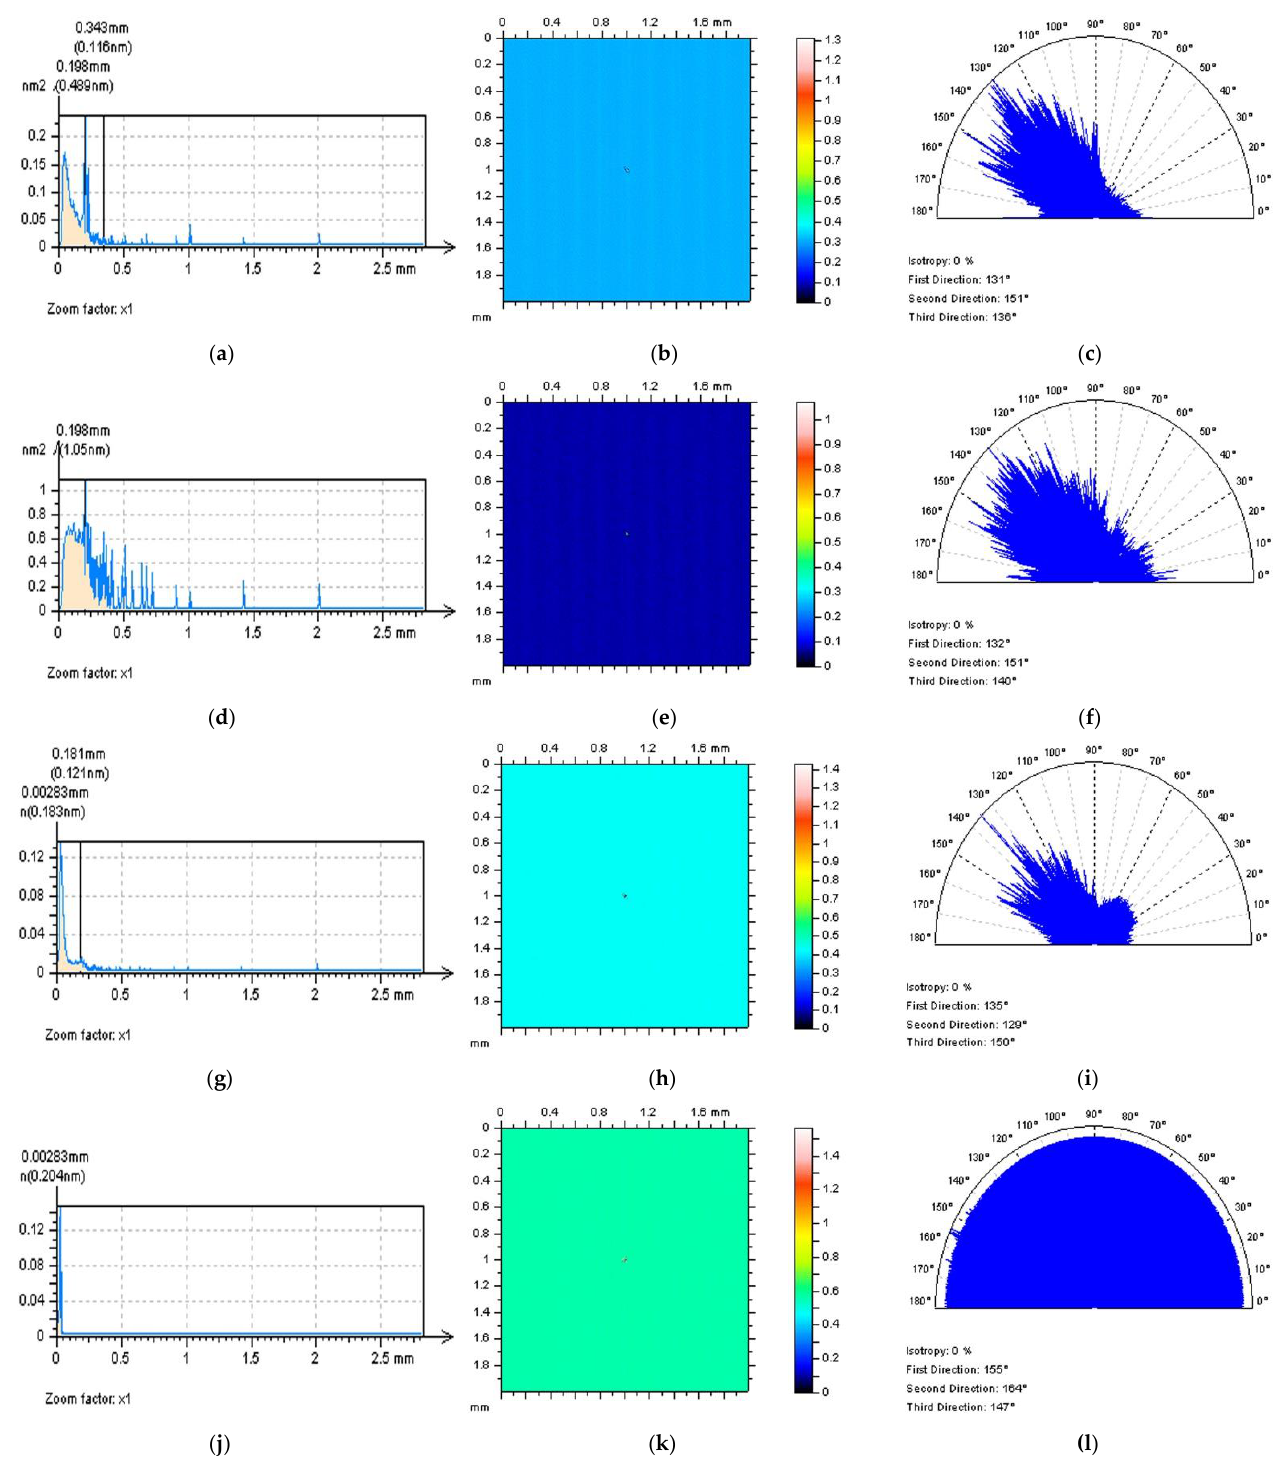
Figure 2. The turned surface after noise removal: contour map plots of the data with removed noise ( a , d , g , j ), contour maps plots of NSs ( b , e , h , k ), and the ISO 25178 topography parameters of the sur- face after noise reduction ( c , f , i , l ), respectively, received after application of GF ( a – c ), RGF ( d – f ), SF ( g – i ), and FFTF ( j – l ). Cut-off = 0.015 mm.